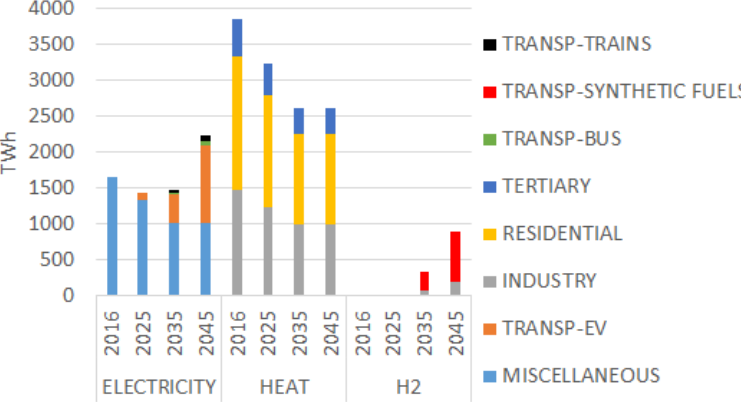
Figure 4. Exogenous demand scenario per year, sector, and commodity (TWh). Transport demand is only included in the scenarios with the transport sector. The year 2016 is the base year of the model and is not included in the